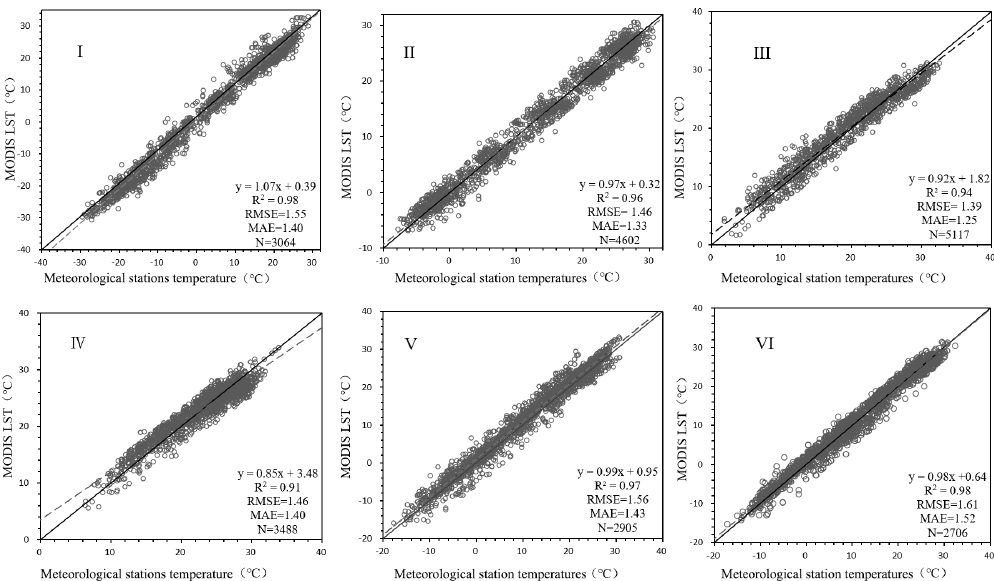
Figure 5. Scatter diagrams of original MODIS LST monthly data (MOD11C3–MYD11C3) against ground station data ( N is the number of datasets); the statistical accuracy measures ( R 2 , RMSE and MAE) are also indicated.